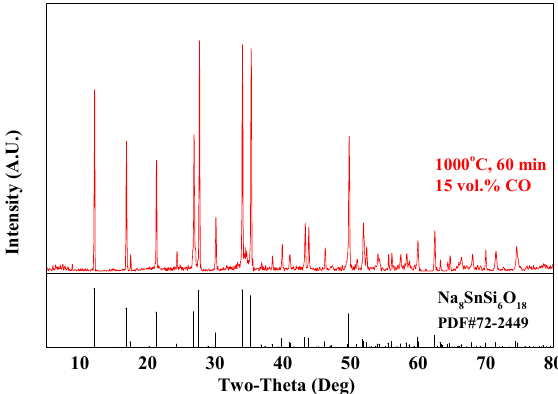
Figure 10. XRD pattern of the synthetic Na 8 SnSi 6 O 18.